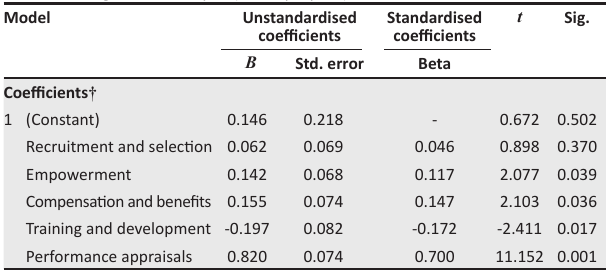
TABLE 4a: Regression analysis (all employees).